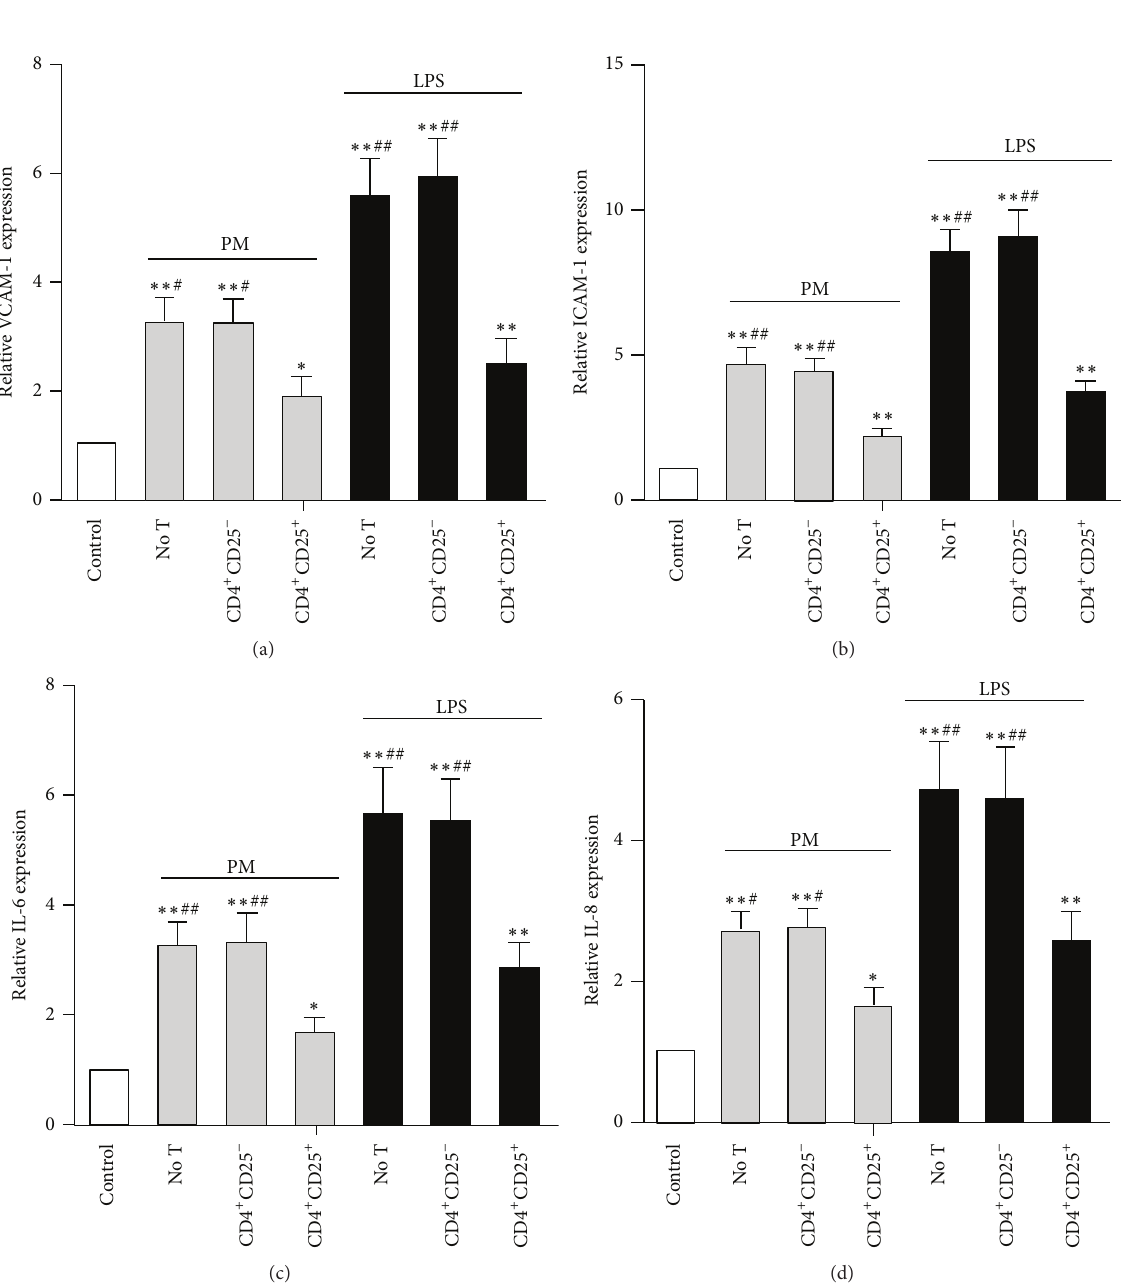
Figure 5: Tregs downregulate the mRNA expression of adhesion molecules and inflammatory cytokines in PM-exposed HUVECs. RT- PCR was used to detect the mRNA expression of VCAM-1 (a), ICAM-1 (b), IL-6 (c), and IL-8 (d) in different groups of HUVECs. Data are expressedasmeans ± SEM. ∗ indicatesnoT,CD4 + CD25 − ,orCD4 + CD25 + versuscontrol; # indicatesnoTorCD4 + CD25 − versusCD4 + CD25 + . ∗ 𝑃 < 0.05 , ∗∗ 𝑃 < 0.01 , # 𝑃 < 0.05 , and ## 𝑃 < 0.01 . Experiments were repeated 5